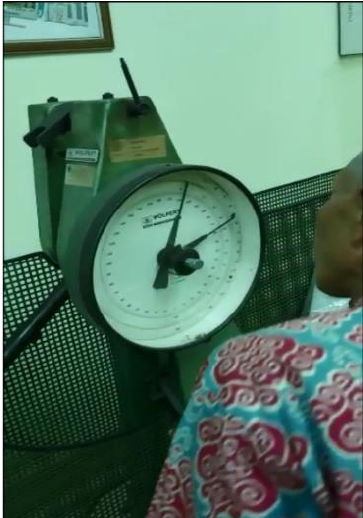
Figure 7. Impact testing process.